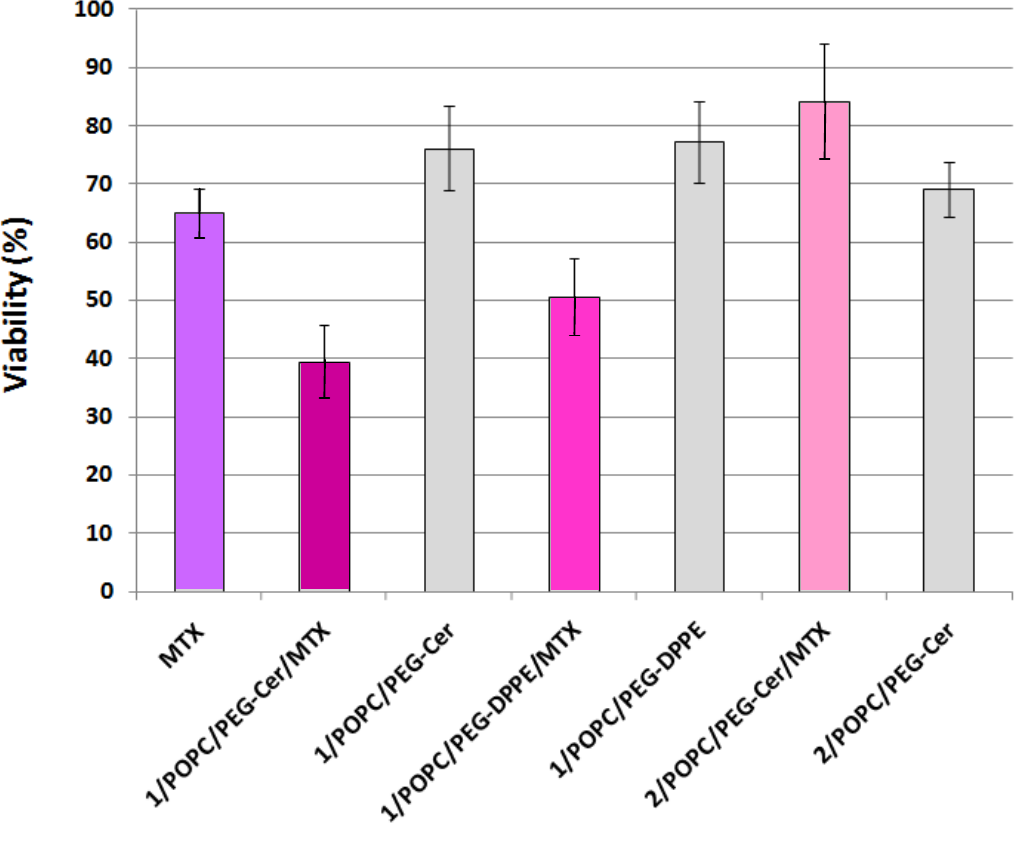
Figure 8. Cytotoxicity of MTX, of the liposome-encapsulated MTX, and of placebo liposomes against HeLa cells. The anticancer cytotoxicity is determined by the MTS assay as the decrease of viability vs. untreated cells (100%